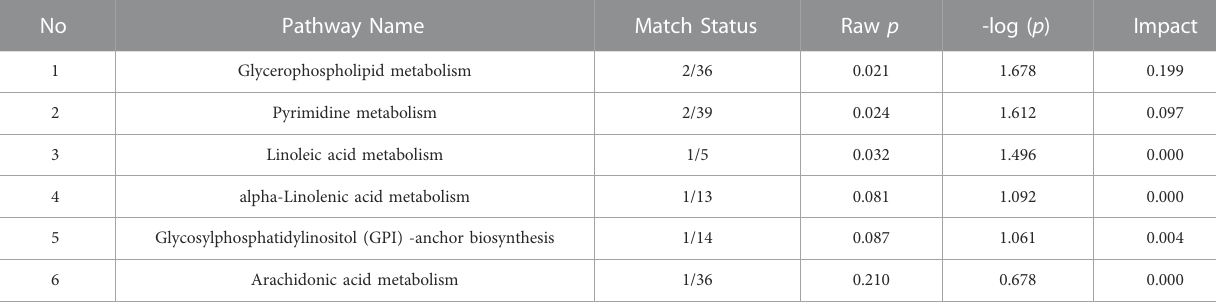
TABLE 4 Analysis of metabolic pathways in serum based on potential